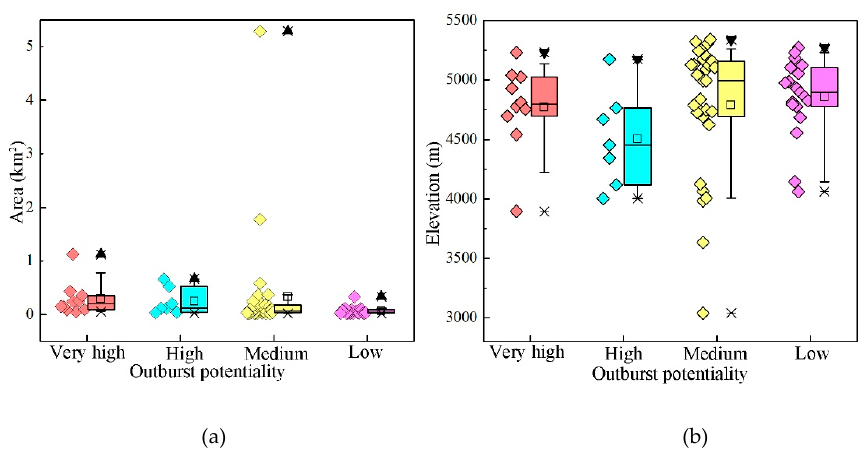
Figure 8. Areas ( a ) and elevations ( b ) of glacial lakes with di ff erent outburst